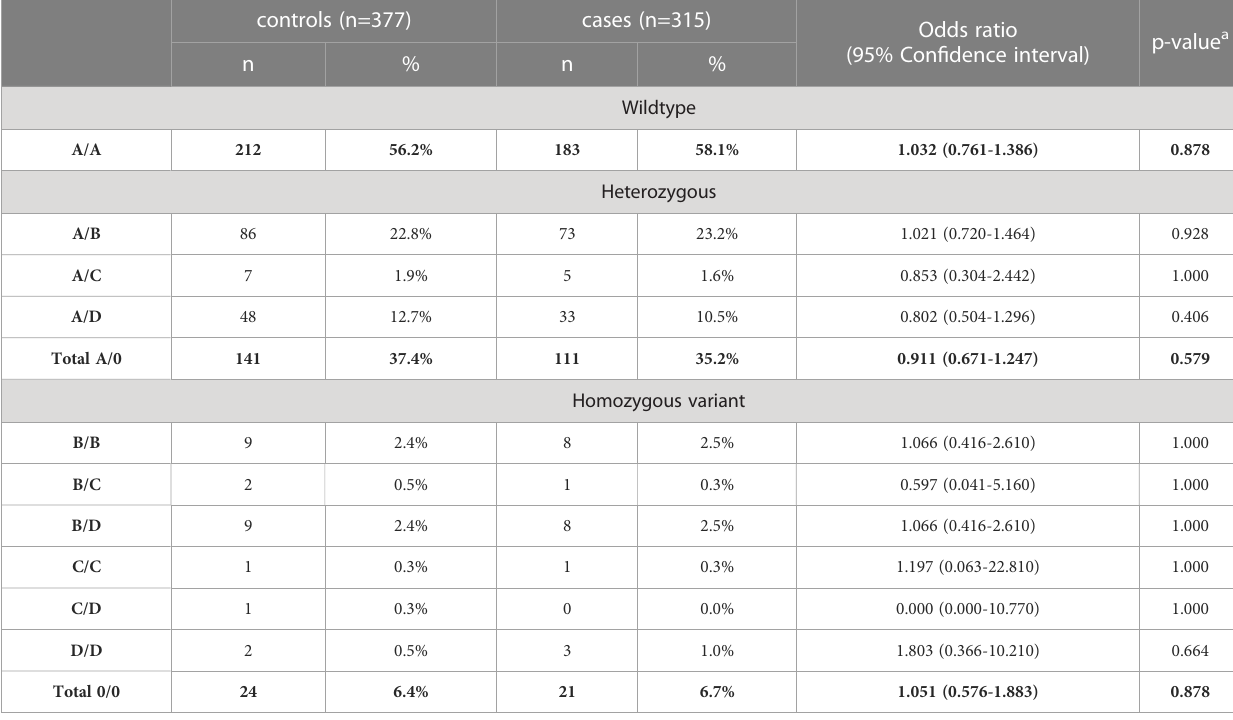
TABLE 3 Distribution of exonic wildtype (A) and variant alleles (B, C, and D) of MBL2 SNPs in healthy controls and cases (merged COVID-19 cohorts (CAM and